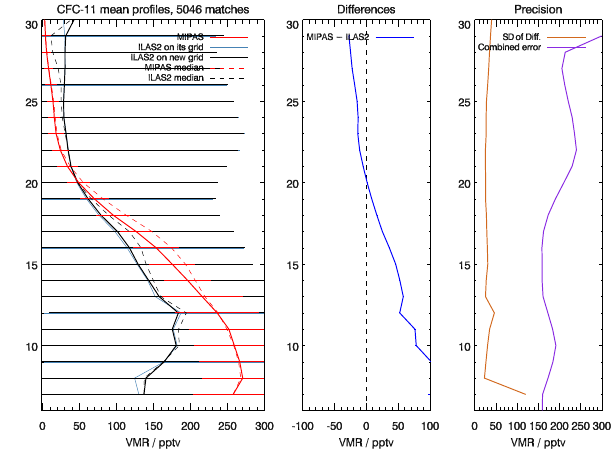
Figure 14. Comparison of mean profiles of MIPAS CFC-11 (left panel, continuous red line) and ACE-FTS (left panel: blue line denotes ACE-FTS on native grid; continuous black line denotes ACE-FTS interpolated onto the MIPAS grid) for February and March 2004, corresponding to the FR period and the MIPAS V5H_CFC-11_20 data set. The dashed lines show the median of each data set. The error bars include the total error for MIPAS and the random errors from the least-squares fitting process for ACE- FTS. The middle panel shows the mean difference (blue) of these profiles and the standard error of the mean. The right panel shows the combined error (purple) of the instruments and the standard de- viation of the differences (brown).